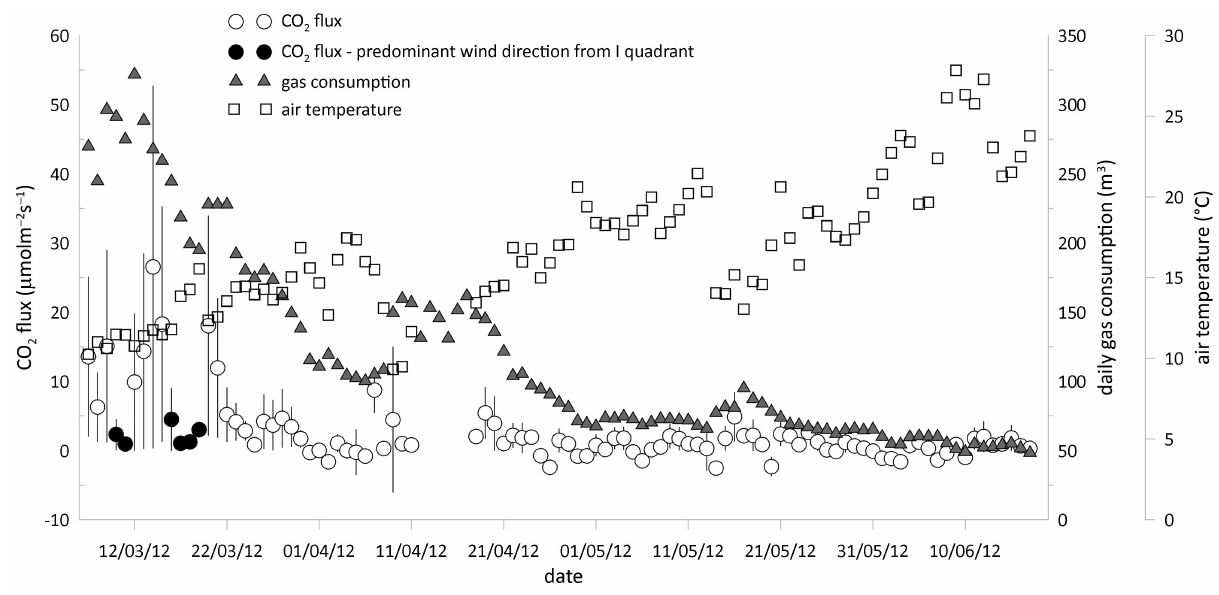
Figure 9. Daily patterns of mean CO 2 fluxes, total gas consumption (courtesy of Amgas Srl Bari), and mean air temperature. The bars on the CO 2 fluxes refer to the mean random